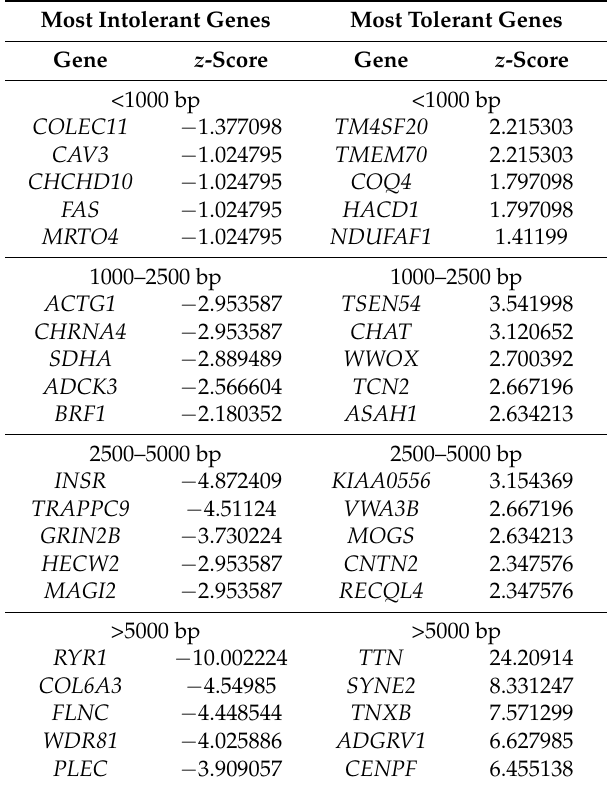
Table 1. List of the five most mutation-tolerant (> z -score) and mutation-intolerant (< z -score) of the 1670 genes associated with metabolic and neurological disorders for the four gene length ranges. Most Intolerant Genes Most Tolerant Genes Gene z -Score Gene z -Score <1000 bp <1000